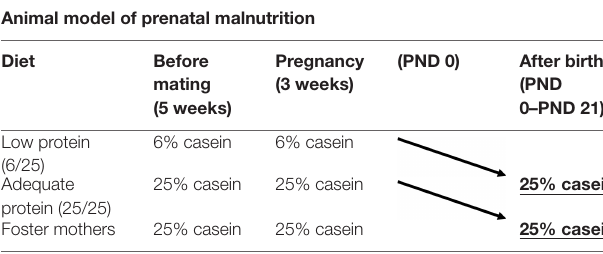
TABLE 1 | Schematic of prenatal nutritional treatment groups. Animal model of prenatal